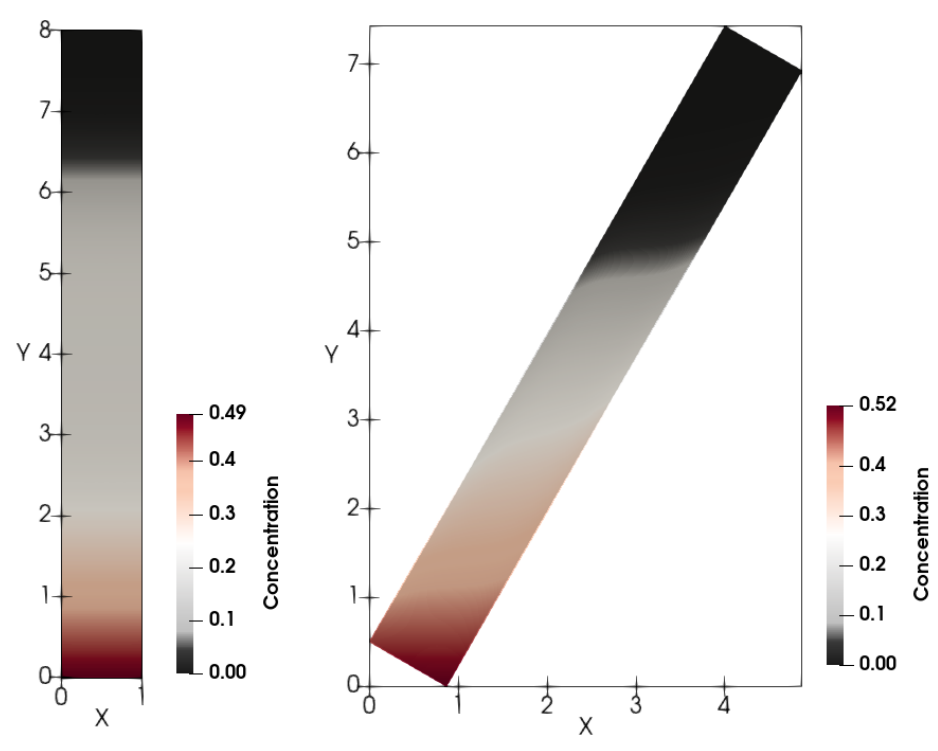
Figure 8. Calculated snapshots of concentration in the case of n = 1 for the flux B rz for both the vertical and tilted vessels. The inclination angle is 30 ◦ .